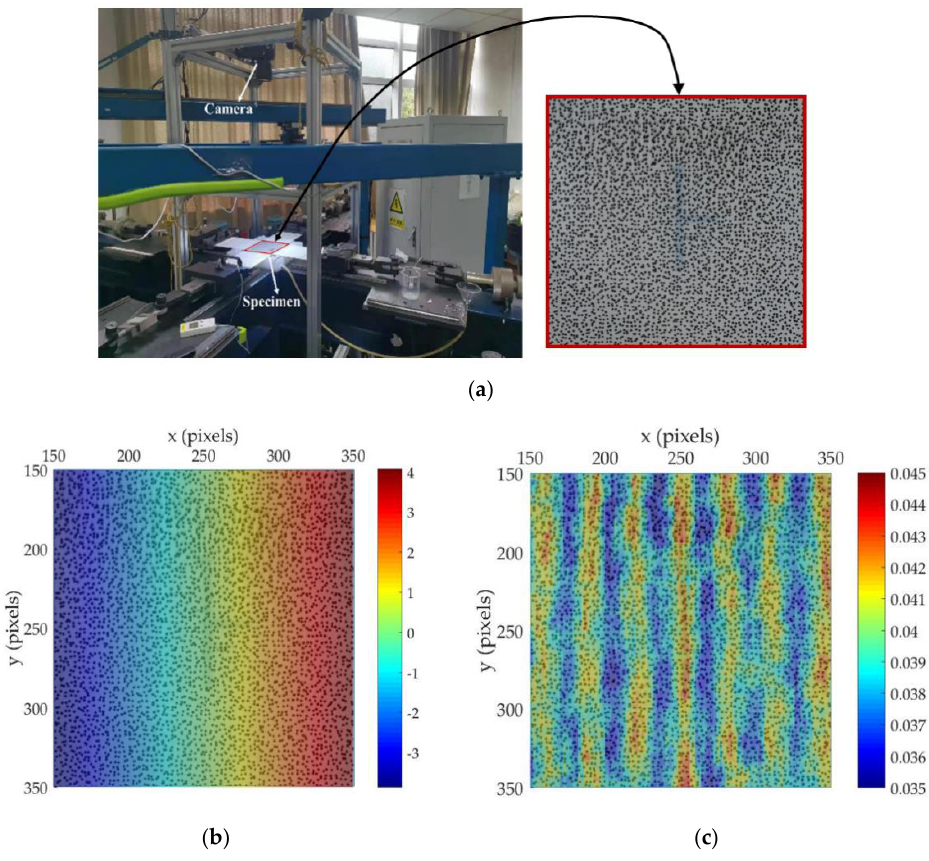
Figure 9. Displacement and strain nephogram in x directions. ( a ) Flash spot region. ( b ) Displacement map in the x-direction. ( c ) Map of strain in the x-direction.